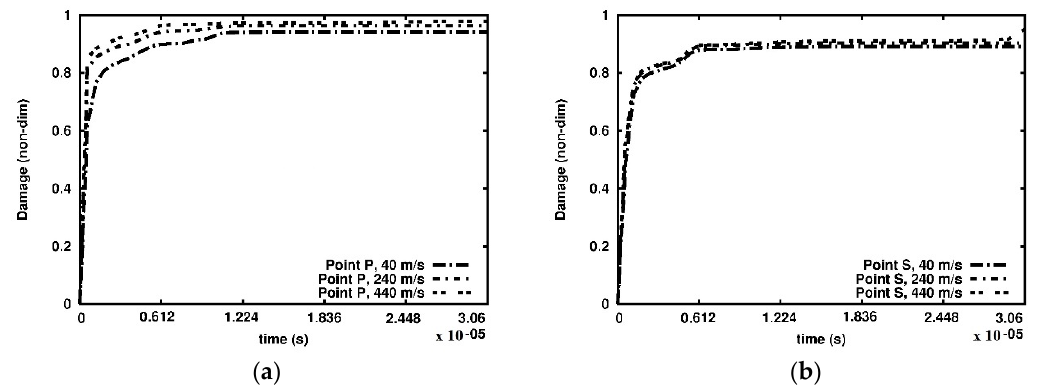
Figure 11. Damage parameter variation, cross-section B-B: ( a ) point Q; ( b ) point T.